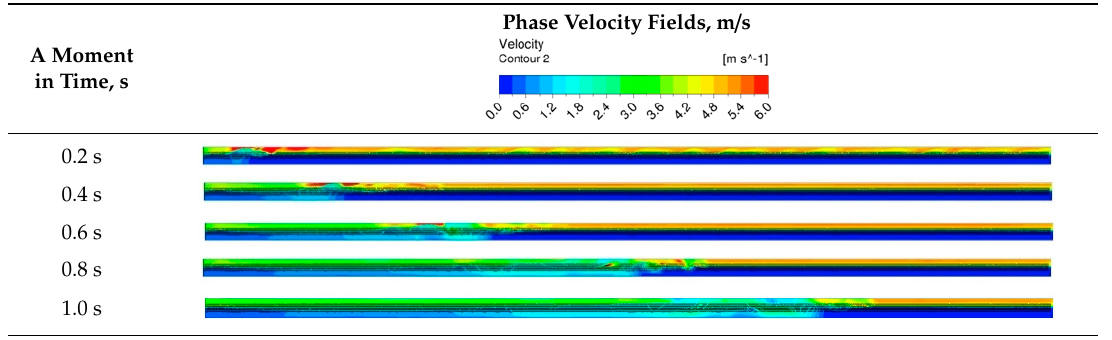
Table 4. Phase velocity fields at different points in time.